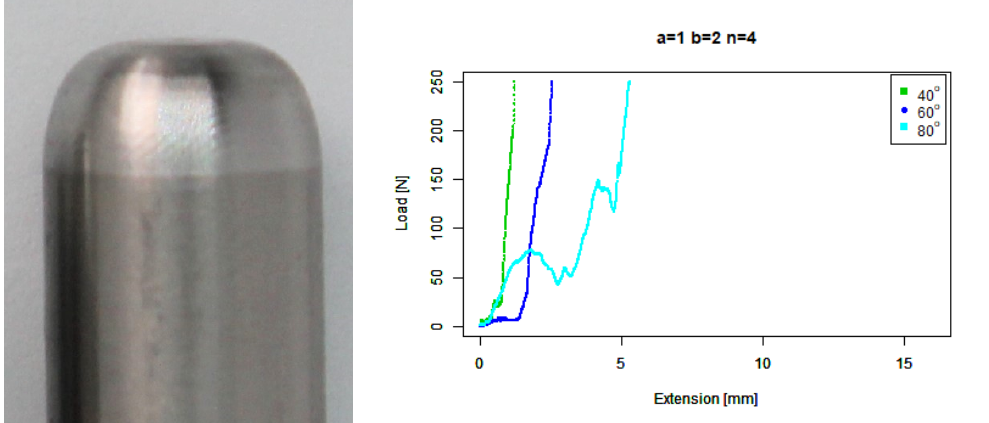
Figure 16. Extruded squircle tip. ( Left ) Tip Profile. ( Right ) Experimental characterisation.